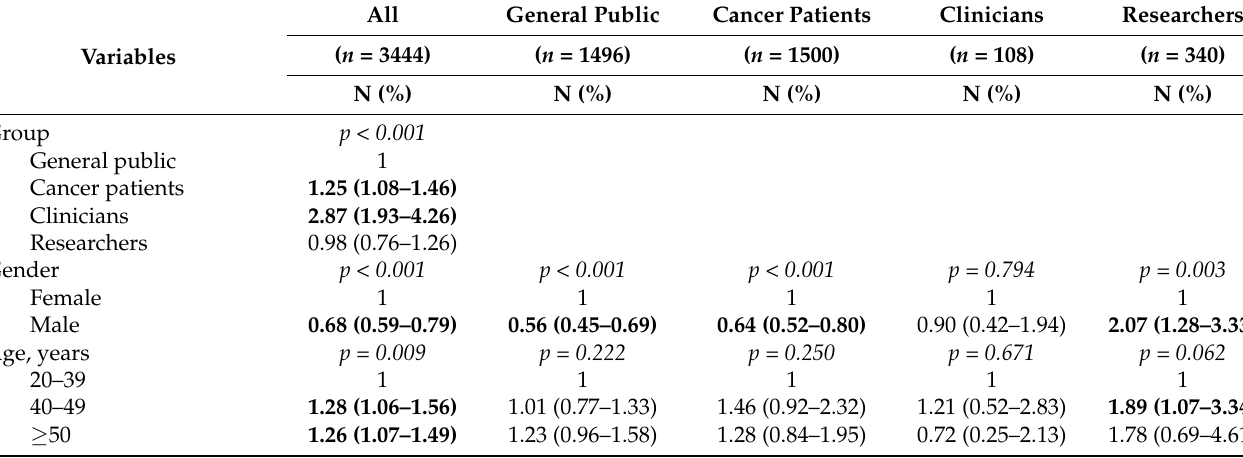
Table 3. Univariate logistic regression analysis of variables associated with intent to undergo risk- reducing